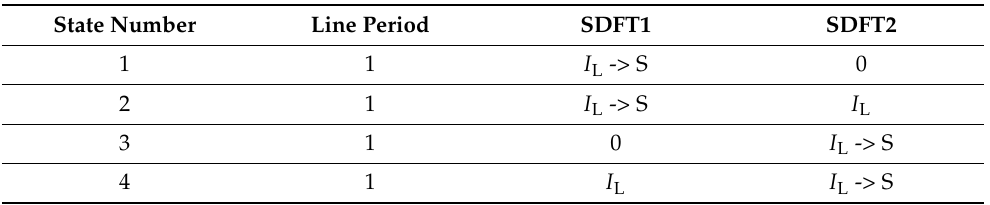
Figure 8. Block diagram of stable “switching” SSDFT. Table 3. Working principle of